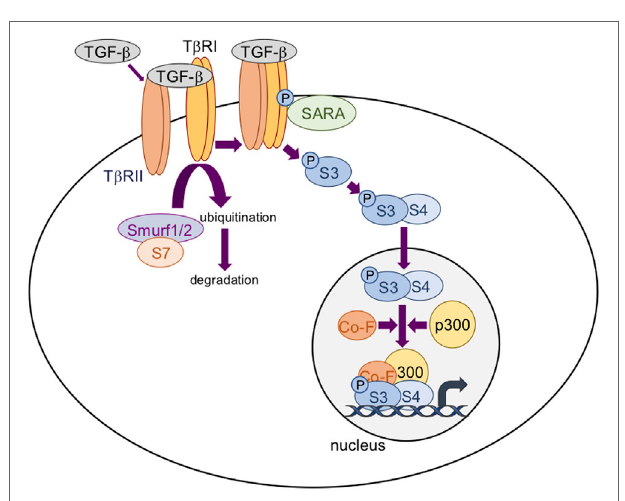
FiGURe 2 | The transforming growth factor- β (TGF- β )/Smad signaling pathway. TGF- β dimers bind to two T β RII receptors that induce the assembly of two T β RI and two T β RII receptors into a heterotetrameric complex in which T β RII phosphorylates and activates T β RI. Smad3 (S3) is then phosphorylated and activated by T β RI. Activated S3 dissociates from the Smad anchor for receptor activation protein (SARA) and recruits Smad4 (S4). This protein complex is translocated into the nucleus to regulate target gene expression in association with cofactors (Co-F) and/or p300. Smad7 (S7) recruits E3-ubiquitin ligases (Smurf1 and Smurf2) to activate TR β I, resulting in receptor